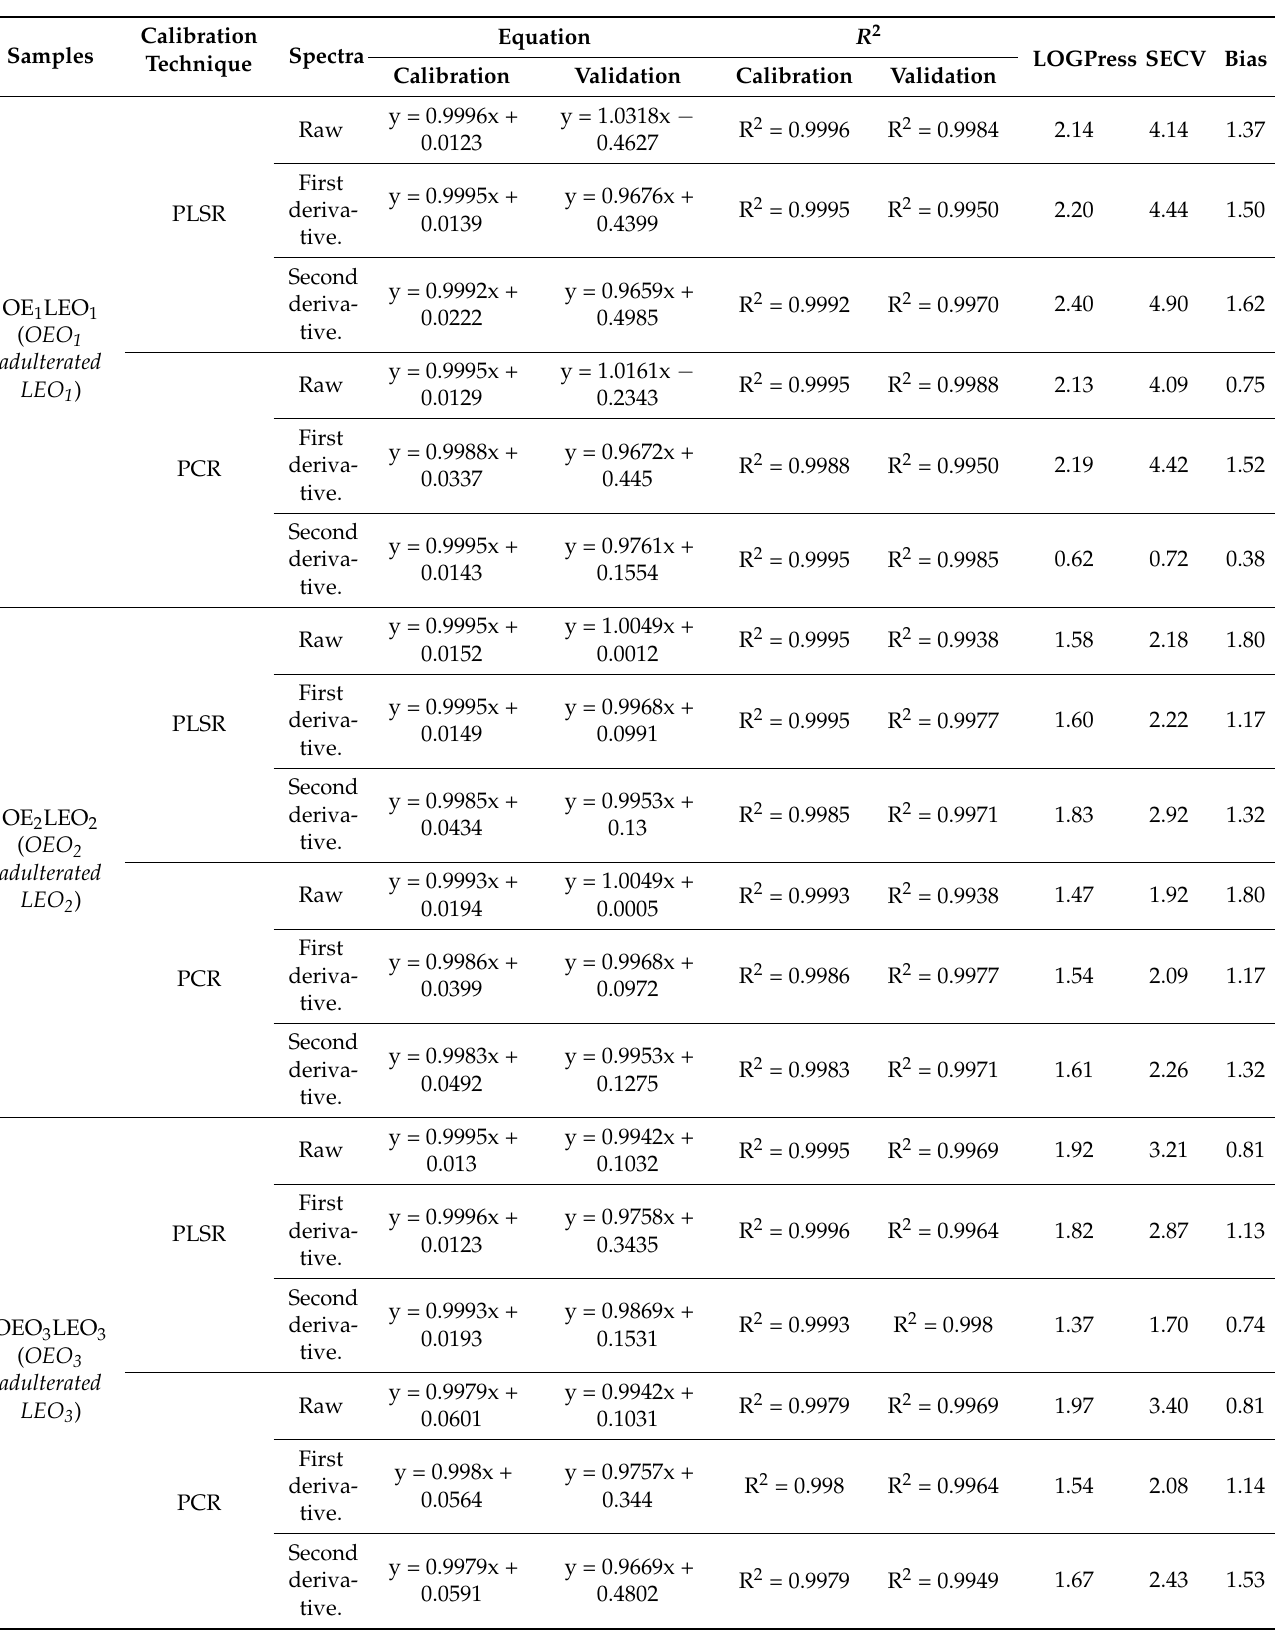
Table 1. PLSR and PCR results of calibration and cross-validation results of raw, first and second derivative FTIR spectra of adulterated lemon essential